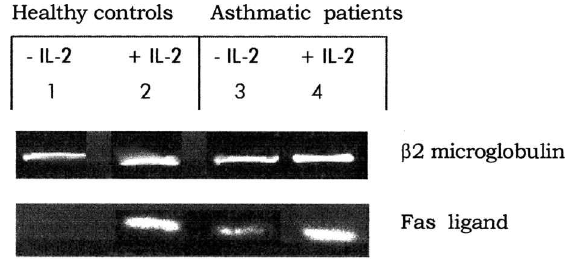
FIG. 3. Expression of FasL mRNA on TCR gd + cells in induced sputum from patients with asthma. The expression of FasL and b 2 microglobulin in freshly isolated TCR gd + cells (lane 1 and lane 3), and TCR gd + cells activated with IL-2 (250U/ml) (lane 2 and lane 4), were analysed by reverse transcriptase- polymerase chain reaction as described in Materials and methods. Representative data from two experiments are